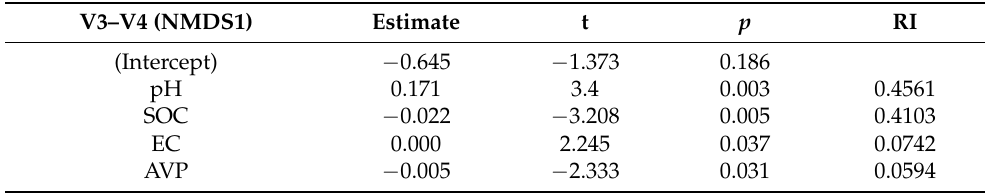
Figure 3. The community structure of abundant and rare soil bacteria in different land uses. Primer pair 520f/802r targeted the V4 region of the 16S rRNA gene; primer pair 338f/806r targeted the V3 – V4 region of the 16S rRNA gene. Table 2. The impacts of environmental factors on the soil bacterial community structure of the sequences obtained using the 338f/806r primer set targeting the V3 – V4 region.